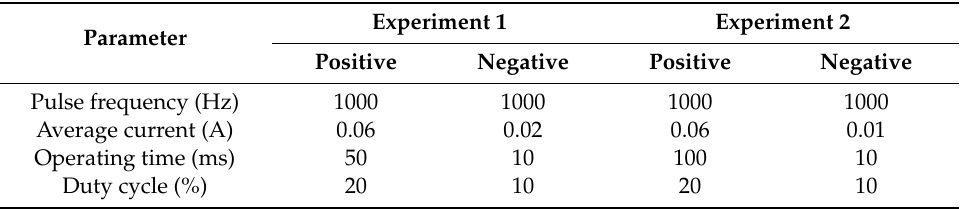
Table 2. Double-pulse electroplating process parameters.